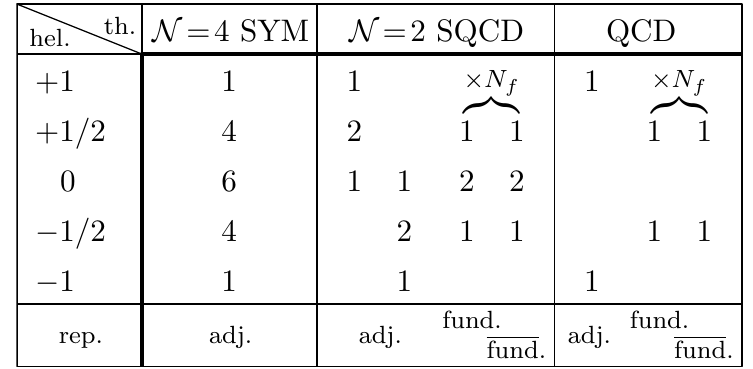
= 4 SYM and conventional N